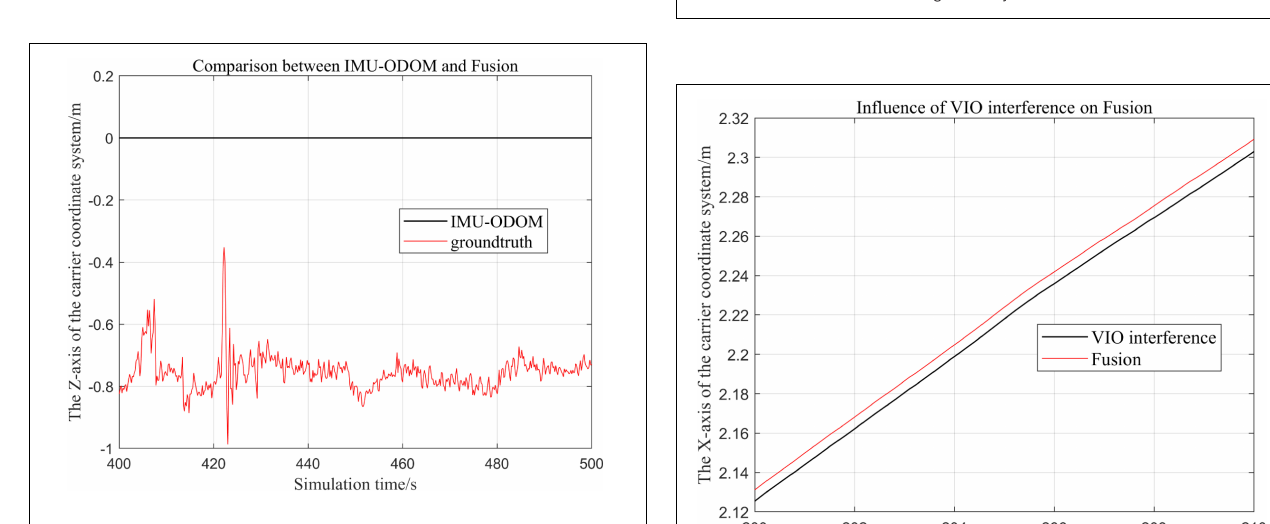
FIGURE 14 | Comparison of z -axis local trajectory of fusion algorithm with IMU and ODOM fusion algorithm.